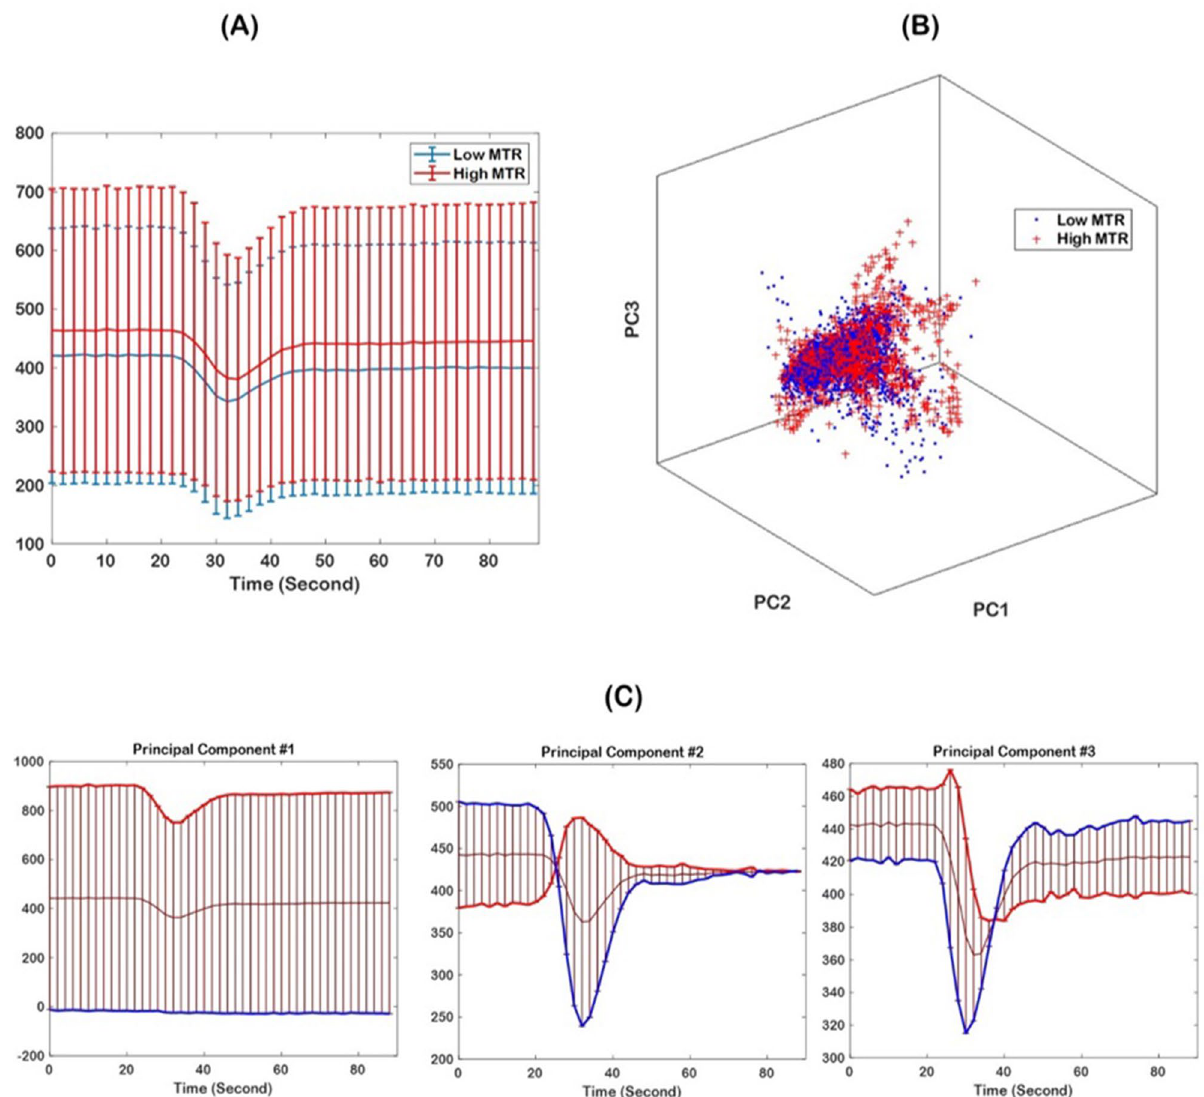
Figure 4. ( A ) Perfusion curves calculated within regions of low and high MTR asym (shown in blue and red colors, respectively), suggesting poor discrimination of the regions solely based on hemodynamic curves. ( B ) Discrimination of low and high MTR asym regions based on PC analysis; PC1 = principal component 1; PC2 = principal component 2; PC3 = principal component 3. ( C ) The three principal components for high MTR asym regions, yielding a marked differentiation of these regions based on the